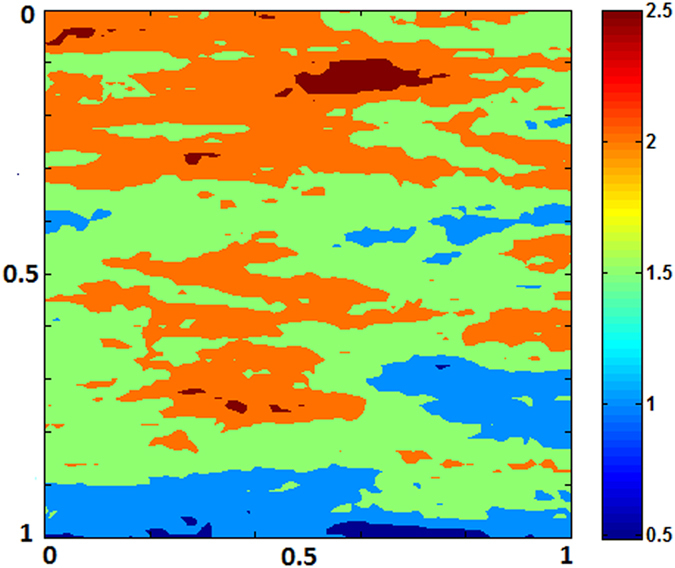
log10k distributions of heterogeneous reservoir.